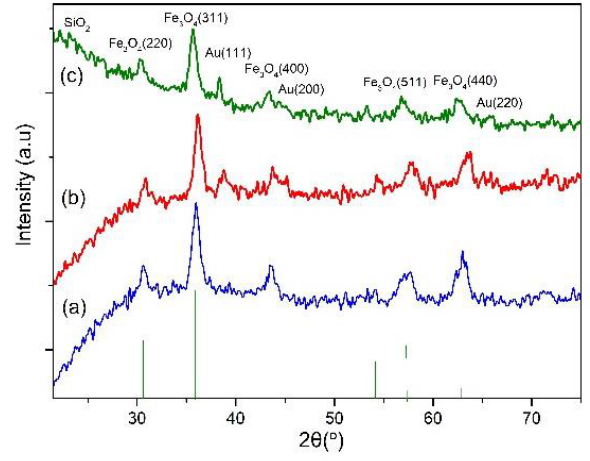
Figure 4. XRD patterns of ( a ) Fe 3 O 4 , ( b ) FOA, and ( c ) FOASET nanoparticles. The main elemental composition of the multifunctional FOASET NC was analyzed by EDX measurement (Figure 5). The Fe, O, Au, Eu, C, and S elements appeared corresponding to a contribution of the nanoparticles of Fe 3 O 4 , Au, and Eu(TTA) 3 complex. The Si, O, C, and N elements were from the formation of an amine-NH 2 -functionalized silica layer. No impurities were found.